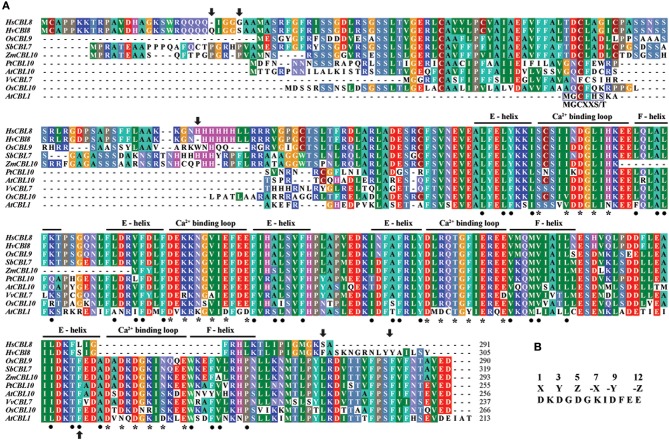
Analysis of the CBL amino-acid sequences. (A) Alignment of the amino-acid sequences belonging to the sub-cluster (II-I-I-II) of some species, including HsCBL8, HvCBL8, OsCBL9, SbCBL7, ZmCBL10, PtCBL10, AtCBL10, VvCBL7, and OsCBL10. AtCBL1 was used as the control. The four EF–hand calcium-binding motifs are clearly indicated. Asterisks and dots denote the amino-acid residues important for calcium binding and the EF–hand structure, respectively. Arrows show the amino acids altered between HsCBL8 and HvCBL8. Conserved myristoylation motifs (MGCXXS/T) in the N-termini of AtCBL1 was marked by a blue box. (B) EF–hand consensus sequence in accordance with Kolukisaoglu et al. (2004).